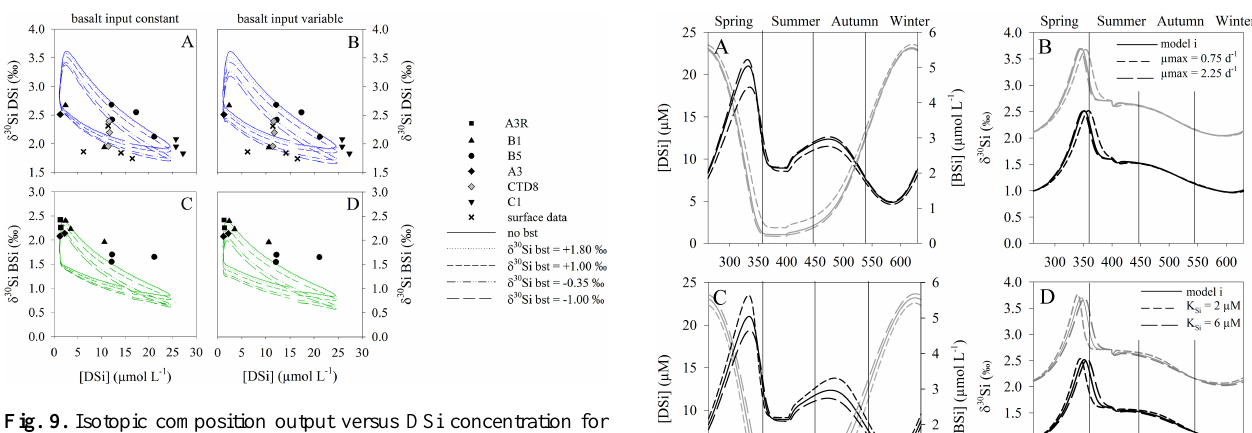
Fig. 9. Isotopic composition output versus DSi concentration for model runs with a constant basalt input (panels A and C ) and with a variable basalt input (panels B and D ). Panels (A) and (B) show δ 30 Si DSi and panels (C) and (D) show δ 30 Si BSi . The surface data are from De La Rocha et al. (2011), stations A3R, B1, B5, A3, and C1 are from KEOPS (Fripiat et al., 2011b) and CTD8 is from this study. Fig. 10. (A) DSi and BSi concentrations with time for model runs